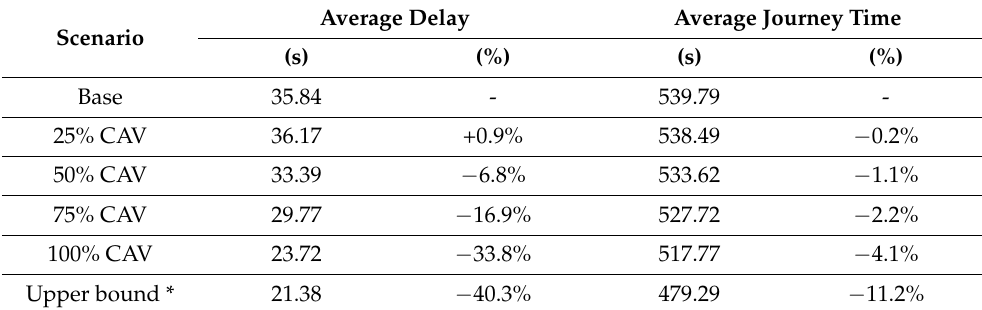
Table 4. VISSIM simulation results for CAVs performance at the strategic road network